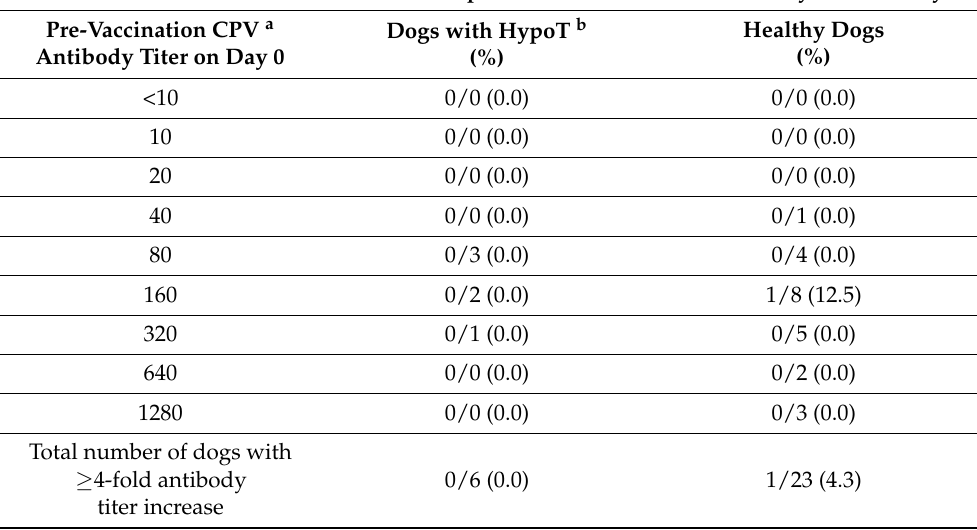
Table 3. Anti-canine parvovirus pre-vaccination antibody titer on day 0 and number of dogs with an ≥ 4-fold titer increase during the course of the